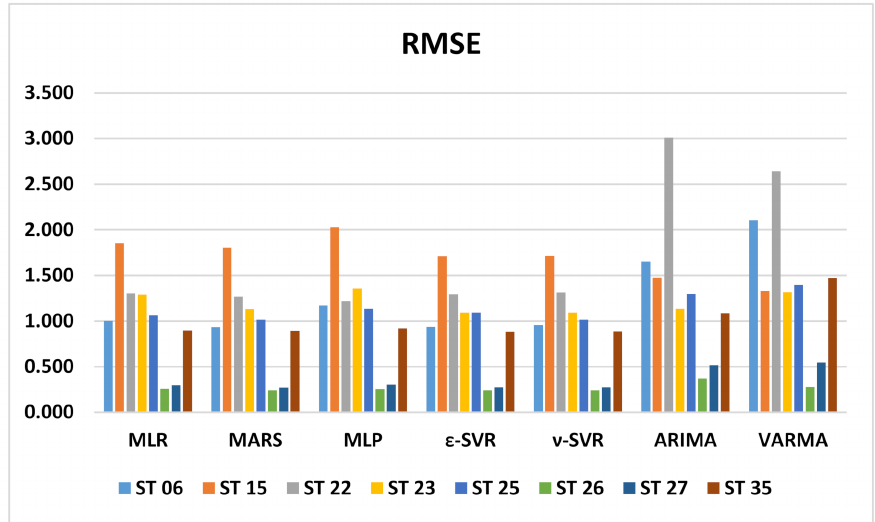
Figure 2. RMSE error for all models and